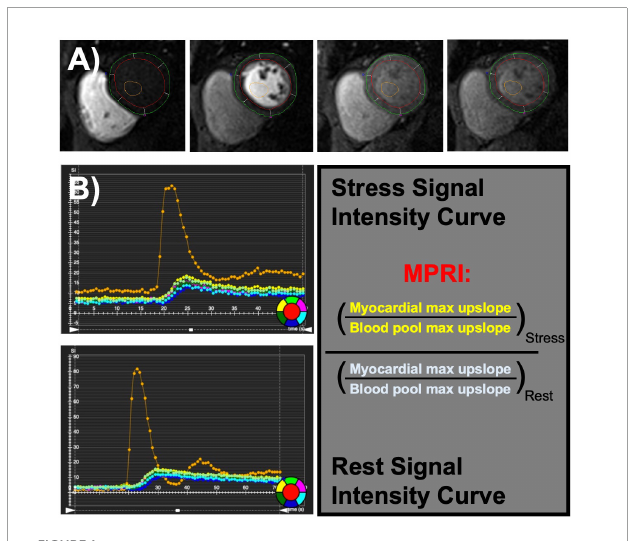
FIGURE1 Coronary microvascular dysfunction can be assessed using semi-quantitative evaluation of first-pass perfusion images (A) during stress and rest cardiac magnetic resonance imaging (MRI). Myocardial perfusion reserve index (MPRI) is calculated by the maximal upslope of myocardial intensity normalized by maximal upslope of blood pool intensity at stress divided by rest (B)